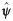
Picazuro Pigeon Patagioenas picazuro occupancy (ψ^) in the regional bird monitoring area in Argentina.Occupancy of the species is represented for (a) 2003, (b) 2006, (c) 2009, (d) 2012.